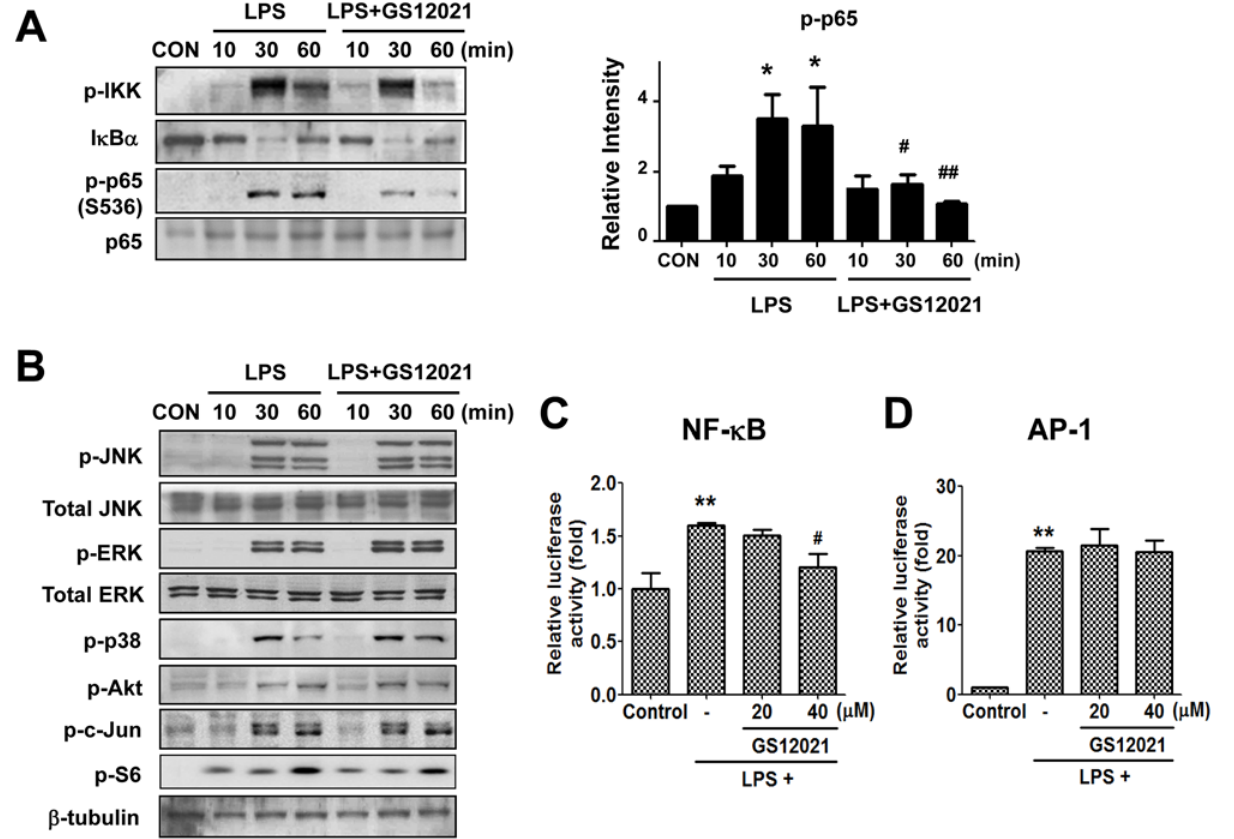
Fig 5. Effect of GS12021 treatment on LPS-stimulated cell signaling in RAW 264.7 cells. Immunoblot analyses of phosphorylated IKK, I κ B α and phosphorylated- and total-p65. The experiments were repeated at least three times, and the representative images and the densitometry results for phosphorylated p65 are shown in (A). Phosphorylations of JNK, ERK, p38 MAPK, Akt, c-Jun and S6 protein (B). Cells were pretreated with vehicle or GS12021 (20 μ M for 1 h) and stimulated with LPS for the time periods indicated. (C) NF- κ B reporter assay (N = 4). (D) AP-1 reporter assay (N = 4). RAW 264.7 cells were transfected with NF- κ B or AP-1 luciferase reporter plasmid and, after 24 h, cells were incubated with GS12021 (20 μ M or 40 μ M) for a further 24 h. ** P < 0.01 versus CON; ## P < 0.05 versus LPS